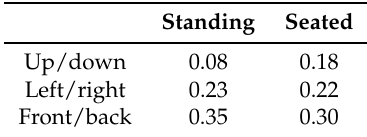
Table 1. Projected area factors of a person